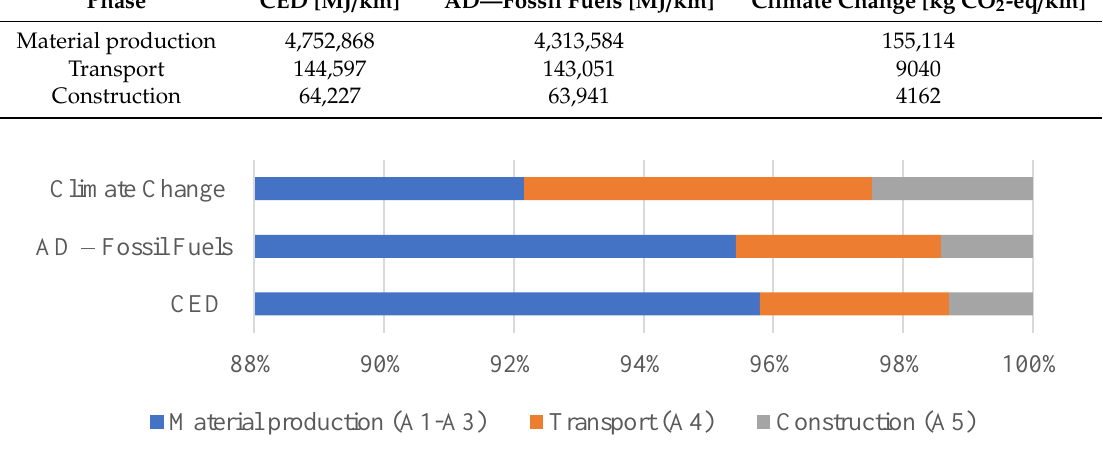
Figure 5. The percentages of the different phases on the overall impact.